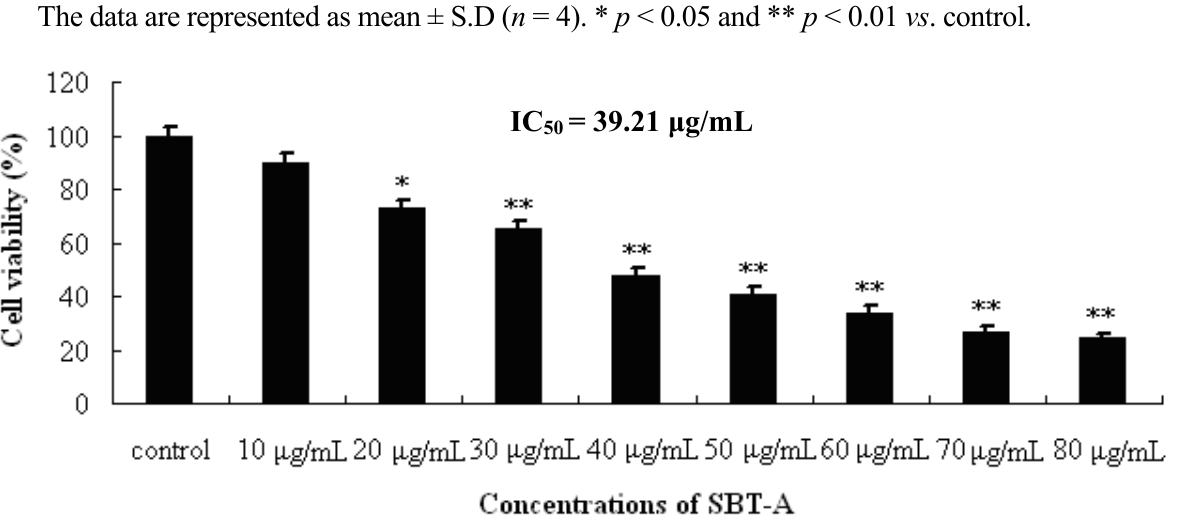
value was 39.21 μ g/mL. 50